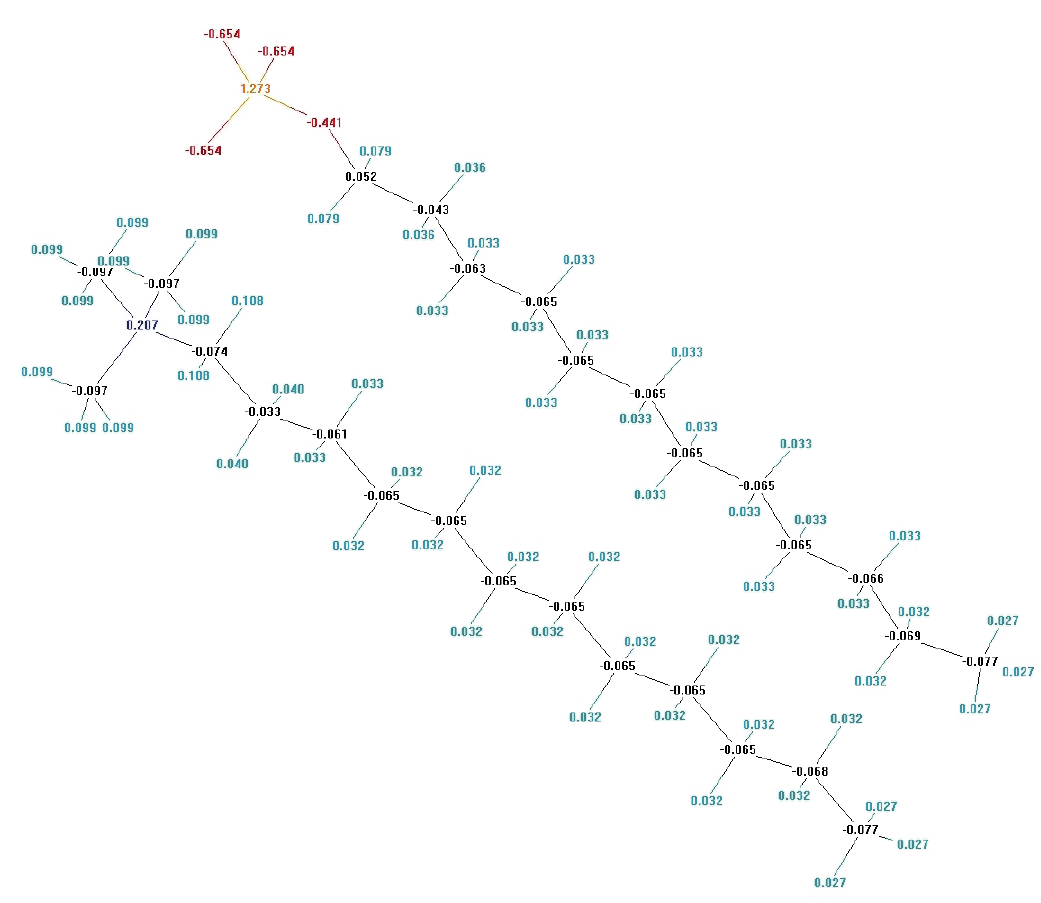
Figure 8: Point charge distribution of DTAB (bottom) and SDS (top) molecules in straight alkyl chain